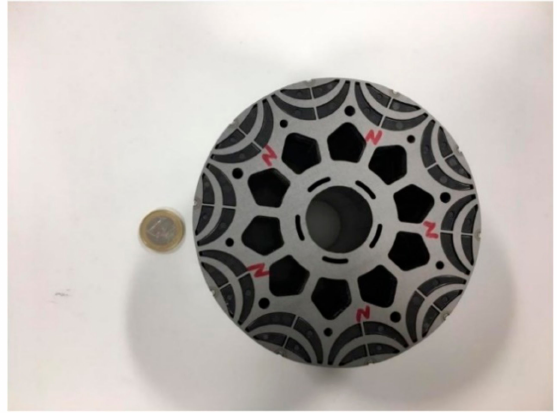
Figure 1. Baseline Motor designed reproduced with permission from [23], Ziwei Li,